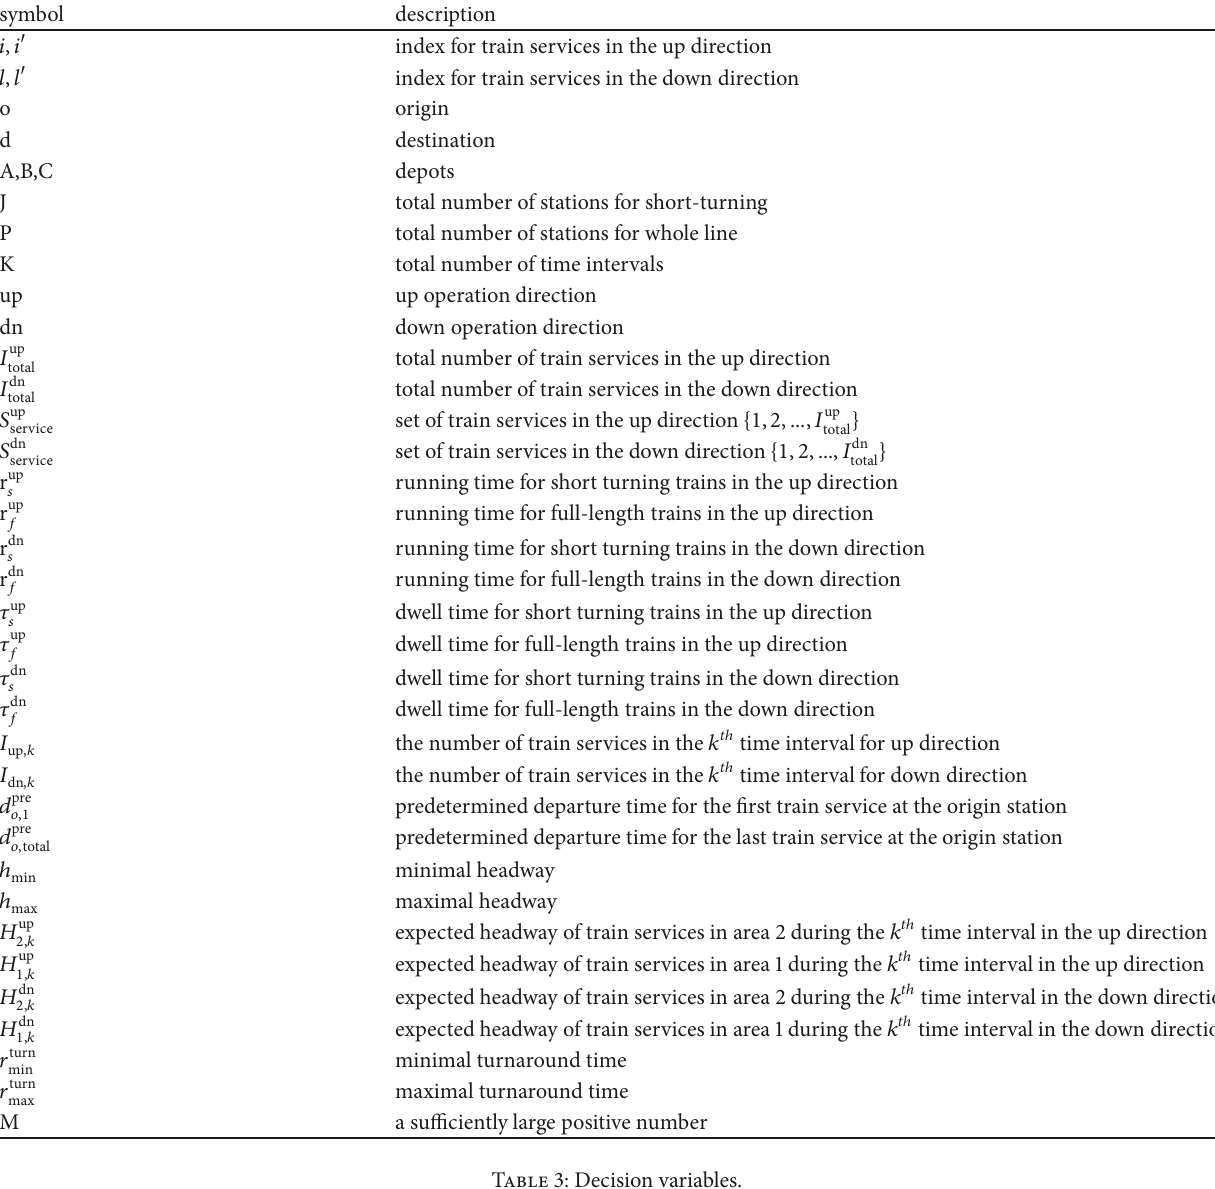
Table 2: Subscripts and parameters.